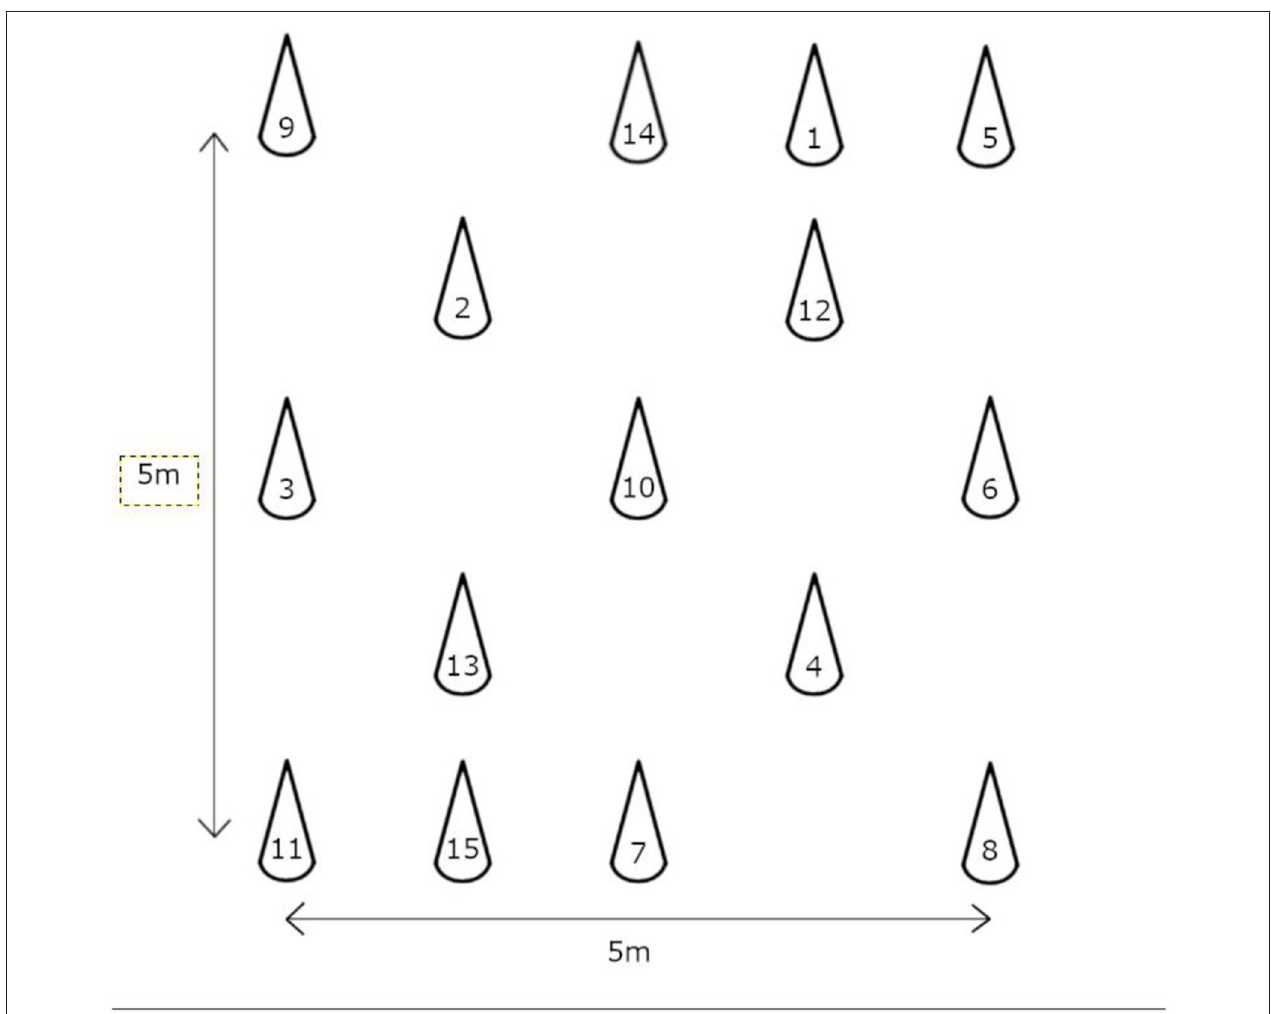
FIGURE 2 | Trail Walking Test (TWT)